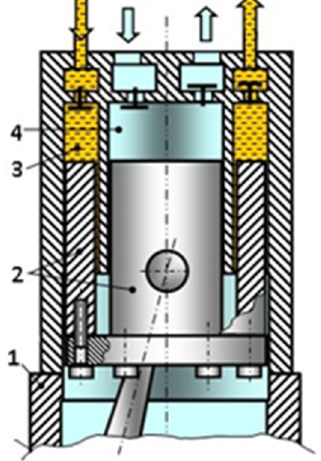
Figure 2. Construction diagram of crosshead-free PHPM (1—crankcase; 2—piston; 3—pumping working chamber; 4—gas working chamber).